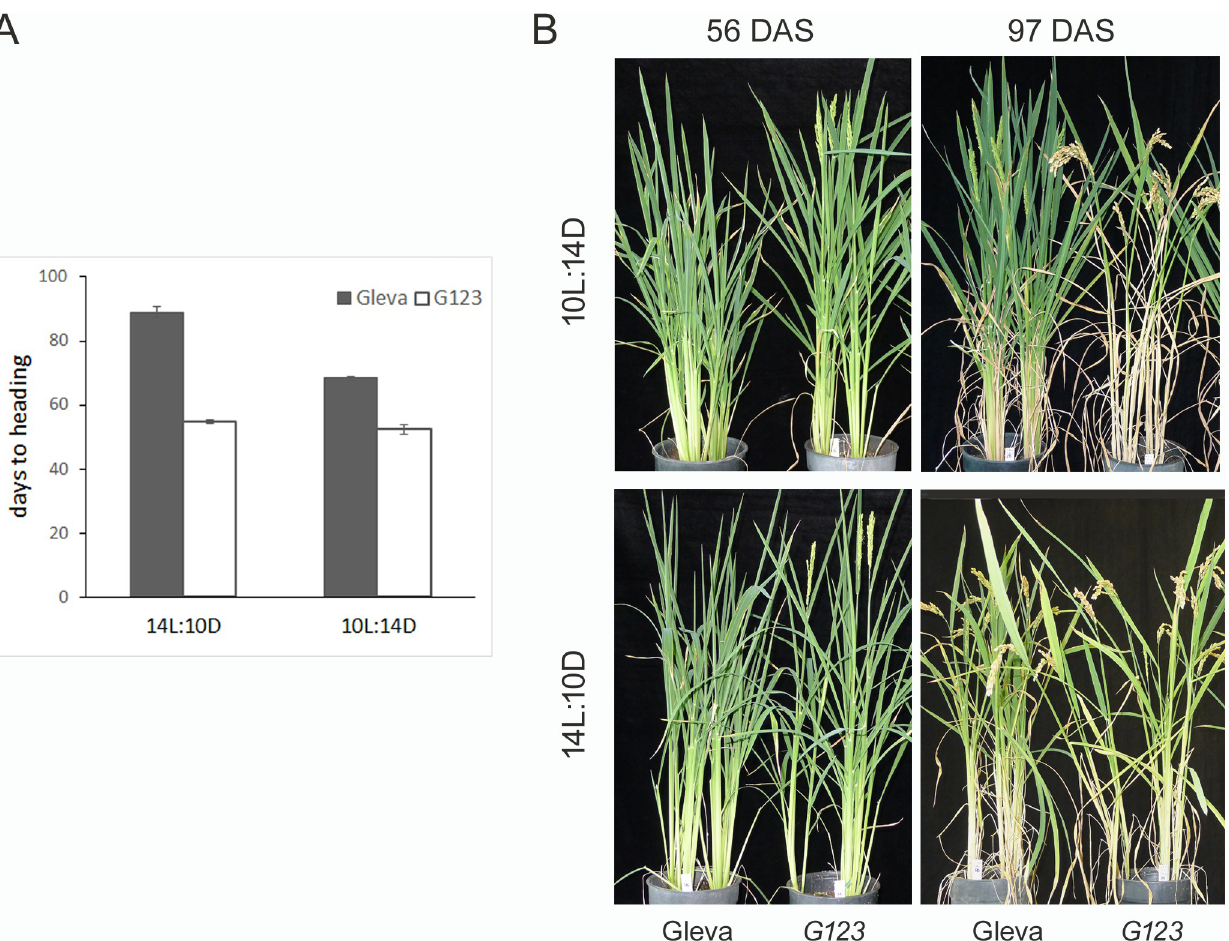
Fig 1. Comparison of the flowering phenotype of the G123 mutant and Gleva wild-type plants. (A) Days to heading under SD (10L:14D) or LD (14D:10D) photoperiod conditions. Days to heading were scored from germination to emergence of panicle from the main culm. (B) Phenotypes of the Gleva wild type and G123 . Plants were grown for 4 weeks under 12 h light:12 h dark photoperiod and then transferred to SD or LD conditions. Plants at 56 or 97 days after sown are shown. https://doi.org/10.1371/journal.pone.0233120.g001 segregated a 289:82 ratio for the plants with a vegetative cycle that was longer or shorter than 72 DAS, respectively, with a 3:1 segregation ratio (chi-squared test: χ 2 = 1. 8, p = 0.18). This indicated that the flowering early phenotype in G123 is conferred by a single recessive mutation.